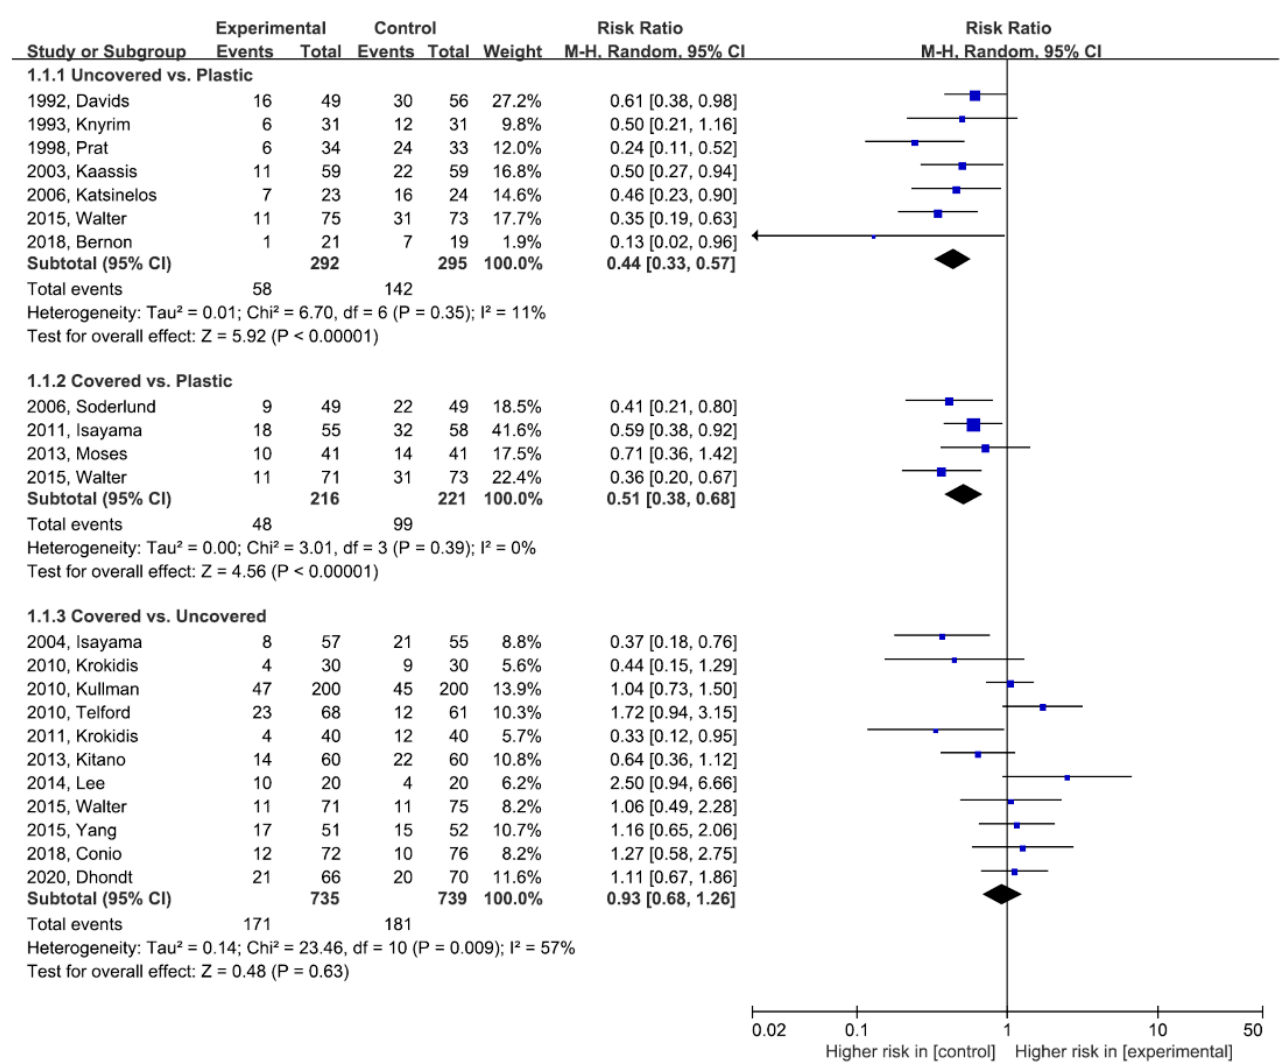
Figure 2. Direct meta-analysis for recurrent biliary obstruction. M-H, Mantel–Haenszel; CI, confidence interval.